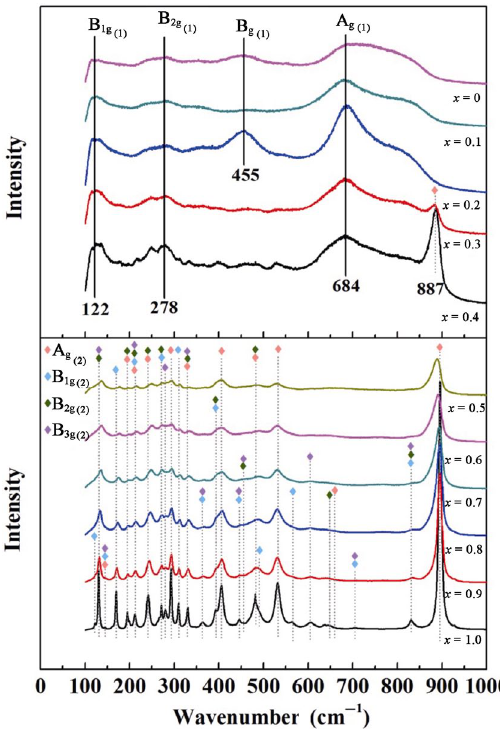
Fig. 4 Raman spectra of (1 − x )CoTiNb 2 O 8 – x ZnNb 2 O 6 ceramics. A g(1) , B 1g(1) , B 2g(1) , and E g(1) were the modes of CoTiNb 2 O 8 ceramics, A g(2) , B 1g(2) , B 2g(2) , and B 3g(2) were the modes of ZnNb 2 O 6